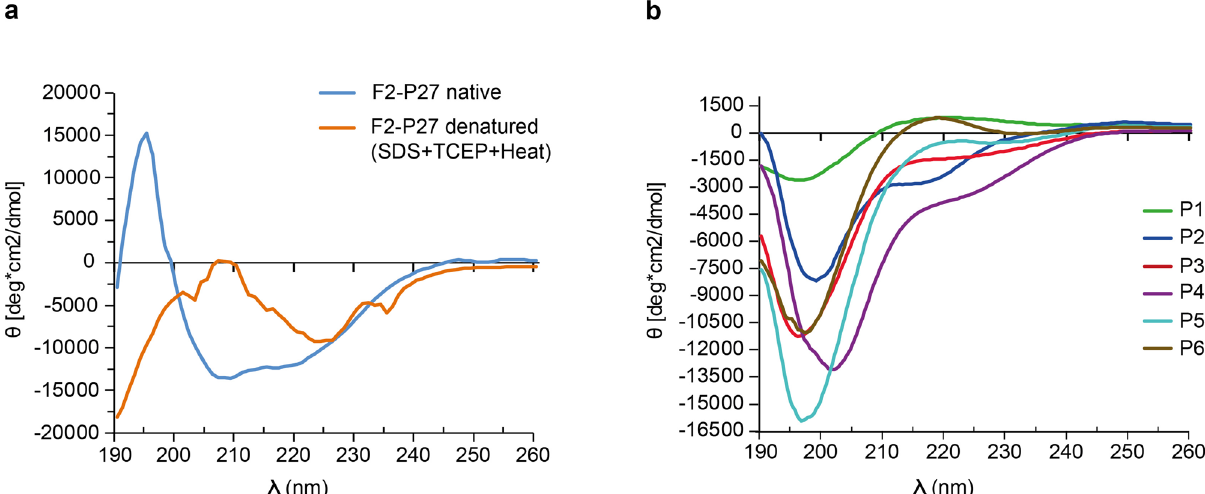
Figure 3. Circular dichroism analysis of recombinant F2-P27 protein subunit and F2-derived synthetic peptides. ( a ) Circular dichroism spectra of native (blue) or denatured (orange) F2-P27 subunit. ( b ) Circular dichroism spectra of F2-derived synthetic peptides (P1: green; P2: dark blue; P3: red; P4: purple; P5: cyan; P6: brown). Mean residue ellipticities (θ) (y-axes) at given wavelengths (x-axes) are